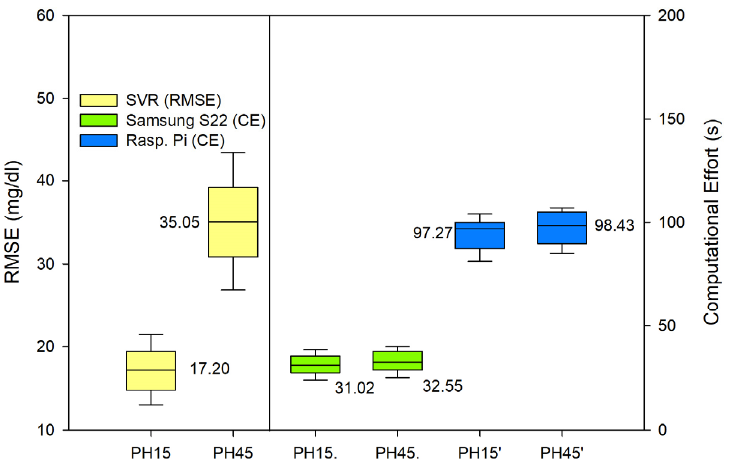
Figure 4. RMSE for SVR predictions. PH 15 min and 45 min. CE of both PH executed in smartphone and Raspberry Pi.